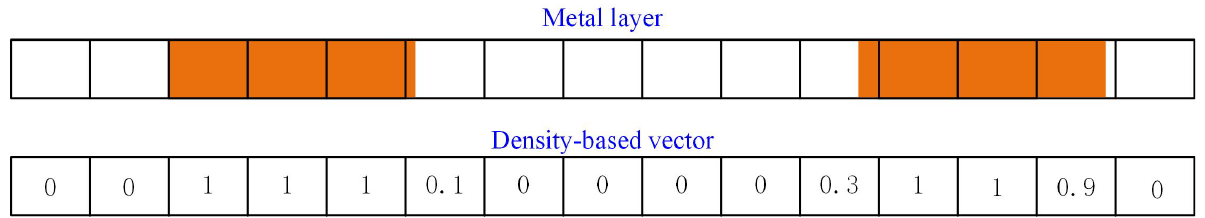
Figure 8. The density-based data representation of one metal layer.